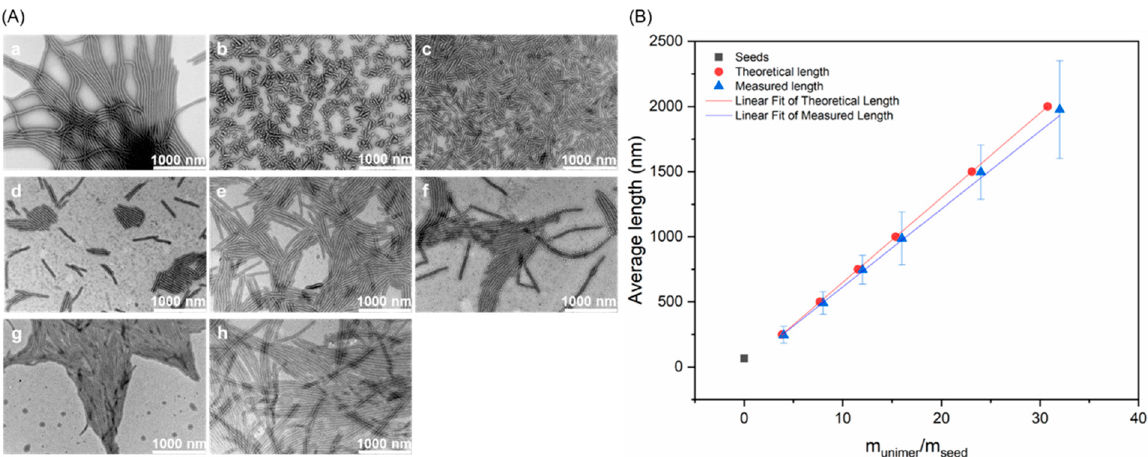
Figure 1. ( A ) TEM micrographs of ( a ) polydisperse cylindrical and ( b ) monodisperse seed micelles. Epitaxial growth of cylinders targeting ( c ) 250 nm, ( d ) 500 nm, ( e ) 750 nm, ( f ) 1000 nm, ( g ) 1500 nm, and ( h ) 2000 nm length values. 1% uranyl acetate was used as a negative stain. Scale bar = 1 μ m. ( B ) Linear epitaxial growth of PCL 52 - b -PMMA 20 - b -PDMA 196 cylinders with narrow length dispersity (blue triangles, error bars represent the standard deviation ( σ ) of the length distribution) in comparison to the theoretical length (red circles). The cylindrical micelles were grown from ca. 65 nm seeds.